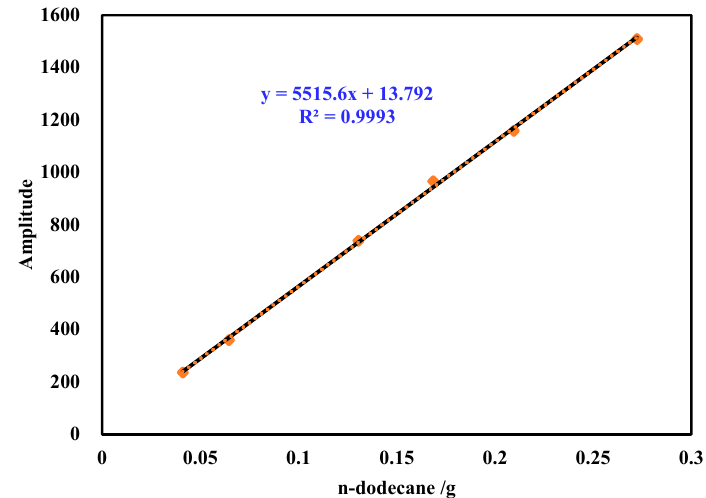
Figure 3. The calibration curve of n-dodecane vs. NMR signal amplitude.